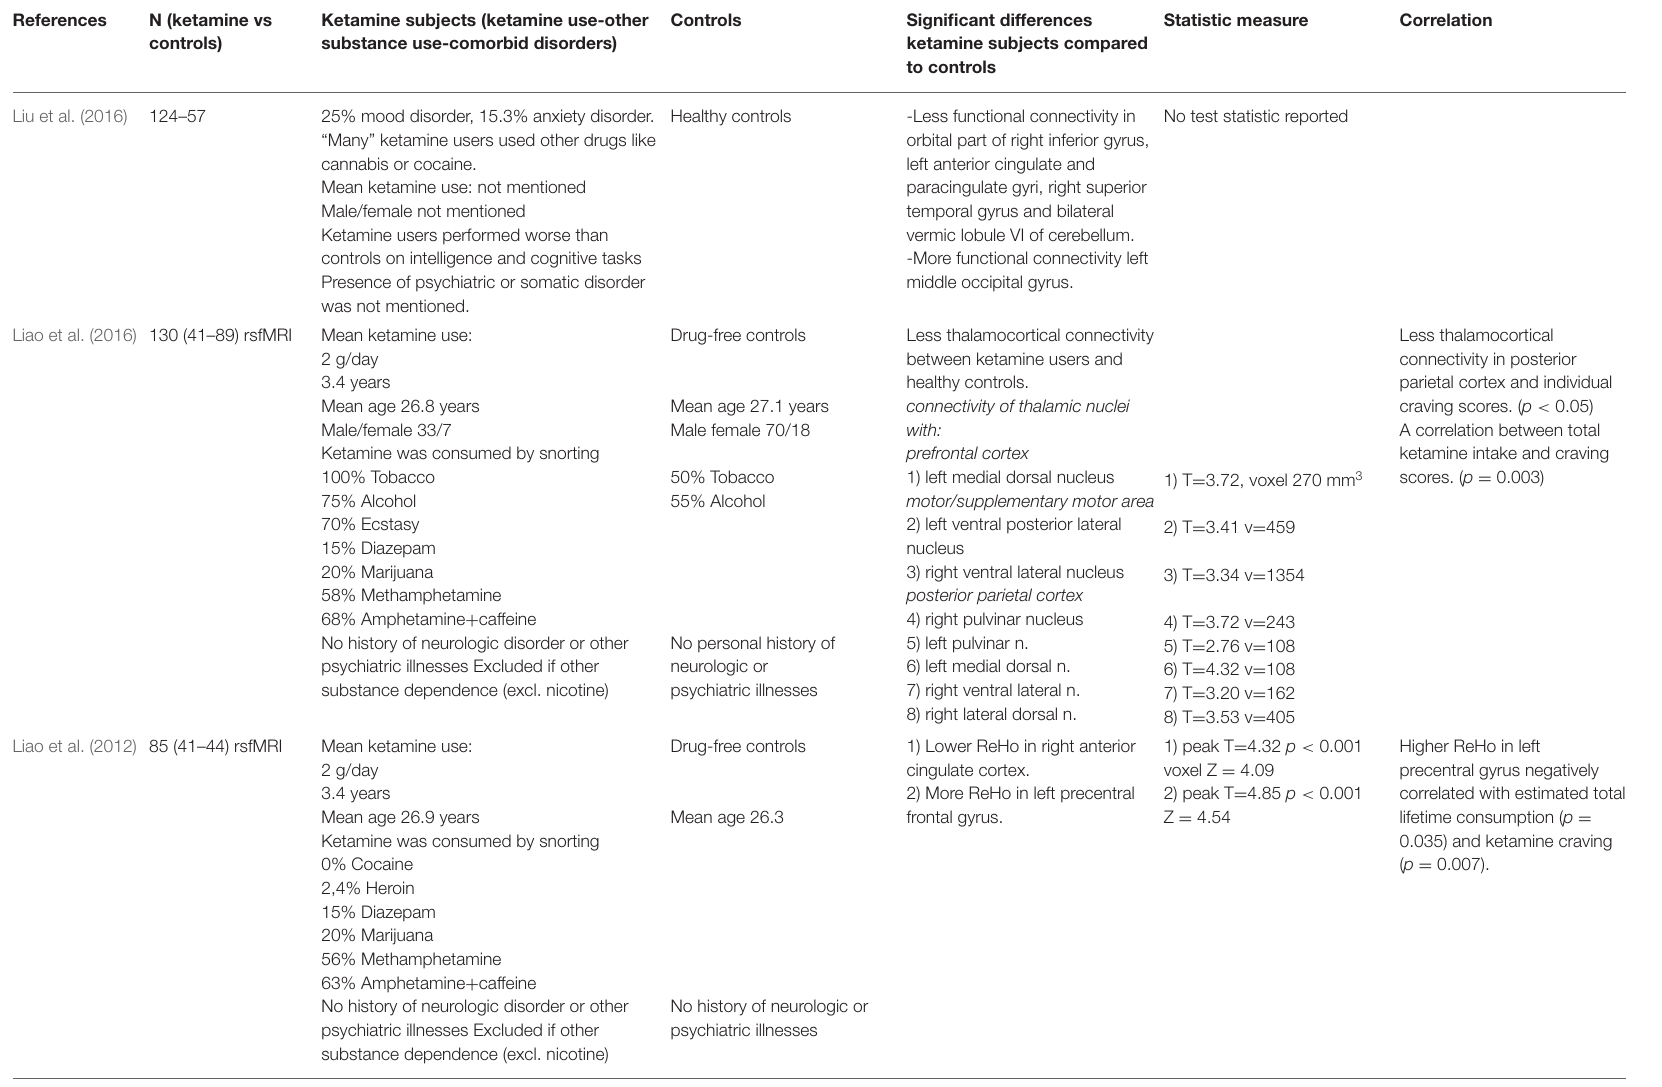
TABLE 3 | Functional